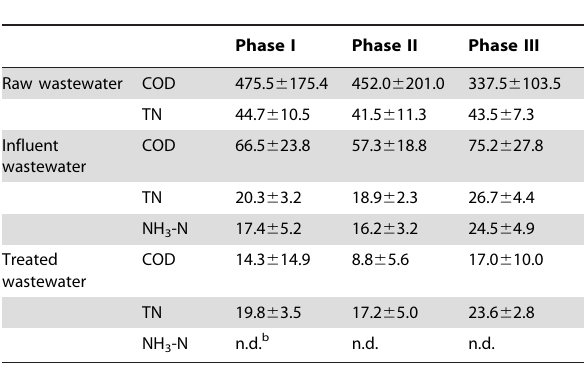
Table 1. Characteristics of the raw, influent and treated wastewater (Unit: mg/L) a